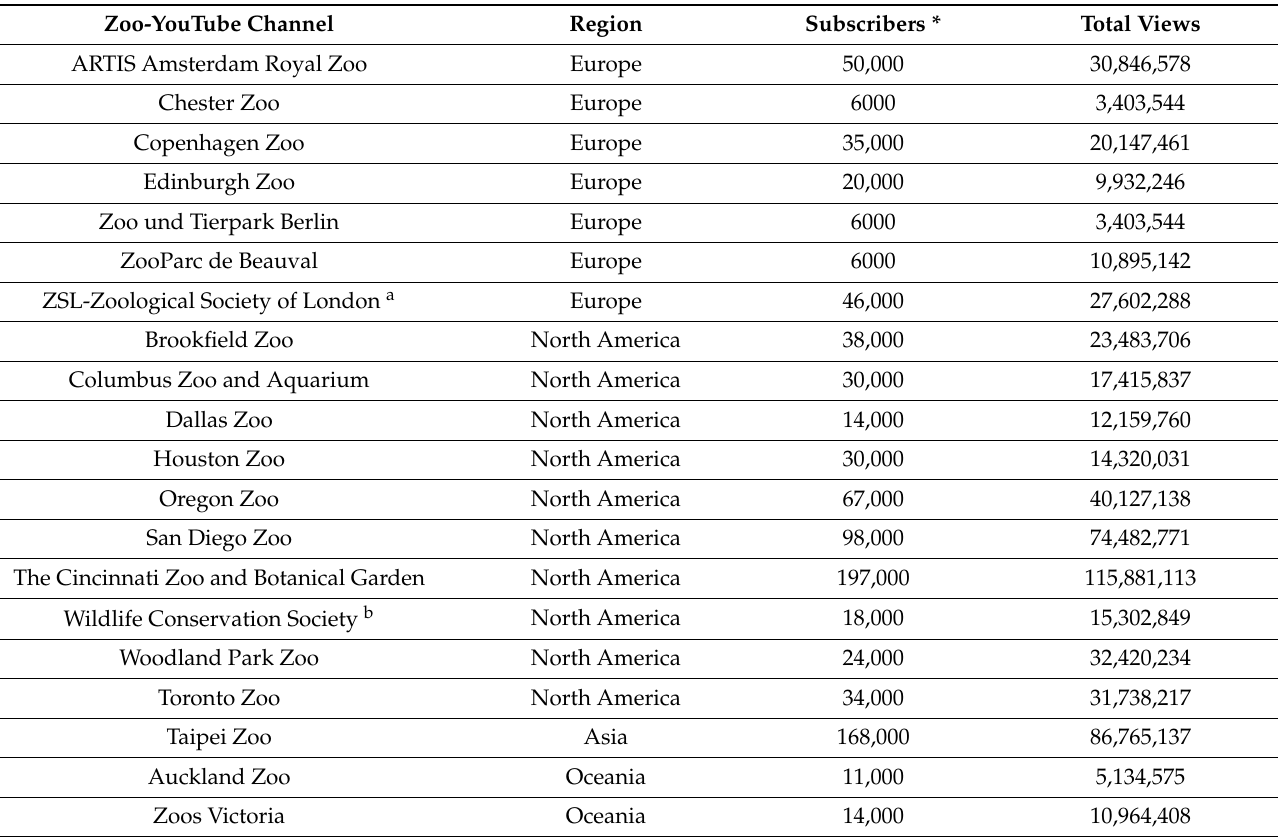
Table 1. Sampled zoo-YouTube